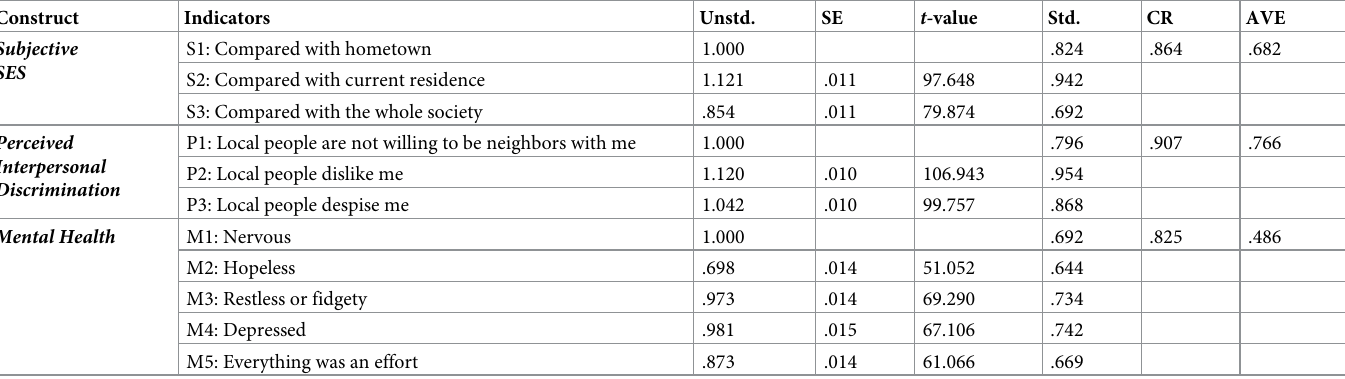
Table 2. Measurement models of key study variables.